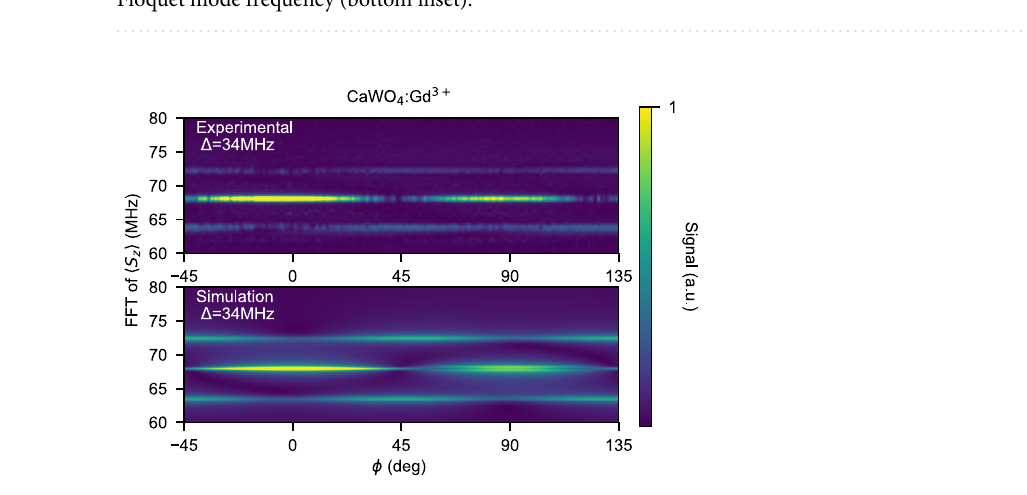
Figure 7. Phase-tunable Floquet dynamics. Rabi oscillations of Mn 2 + at 40 K for two values of φ . For φ (green symbols), h d and h i pulses have the same initial phases resulting in optimally sustained Rabi oscillation. 45 For φ ◦ (orange symbols), strong beatings are observed ( h d , i terms of = simulations using our model with no fitting parameters. The right panel shows the experimental FFT traces. The green one has a well-defined peak at F R while in the other one two peaks (top inset) are separated by twice the Floquet mode frequency (bottom inset).